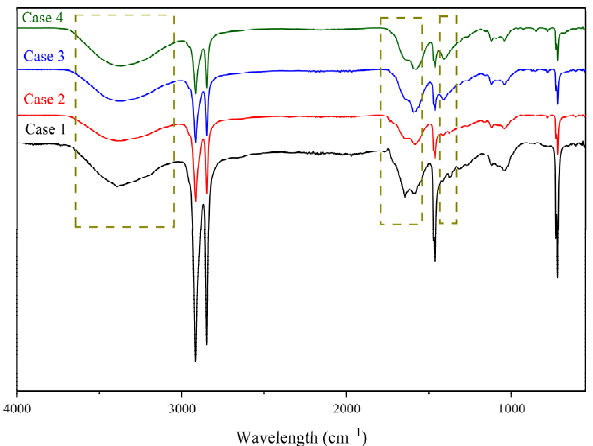
Figure 4. FTIR spectra of the developed biocomposites.